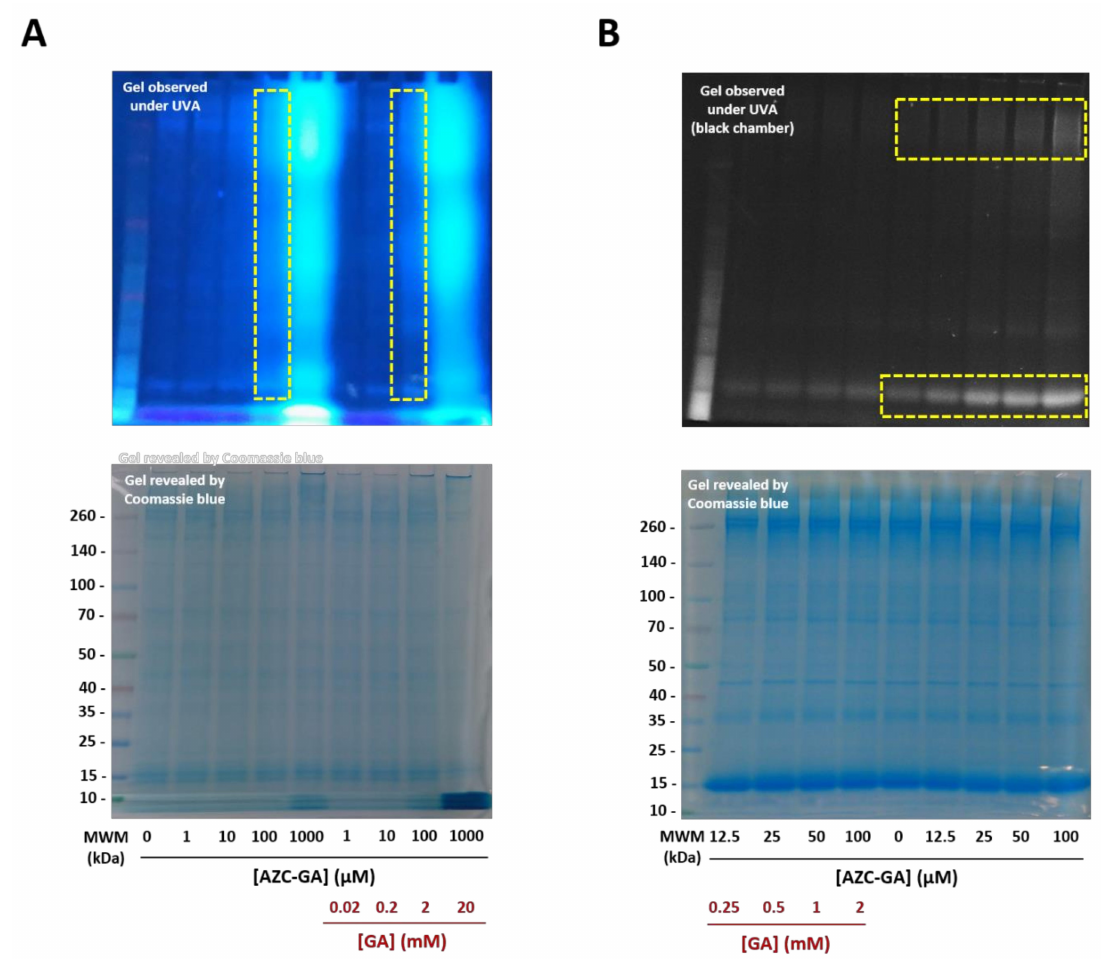
Figure 6. Photoalkylation of asynchronous 3D7 P. falciparum cell lysate by AZC-GA 5 ± GA 1 . ( A ): 0–1 mM range; lysate concentration was 1 mg / mL total protein. ( B ): 0–100 µ M range; lysate concentration was 5 mg / mL total protein. Noteworthy, various plasmodial proteins show slight blue autofluorescence in the absence of AZC-GA 5 (lanes 0 µ M). Fluorescence revelation was performed using the UV bed of an E-Box VX2 scanner (Vilber-Lourmat) and pictured as seen with